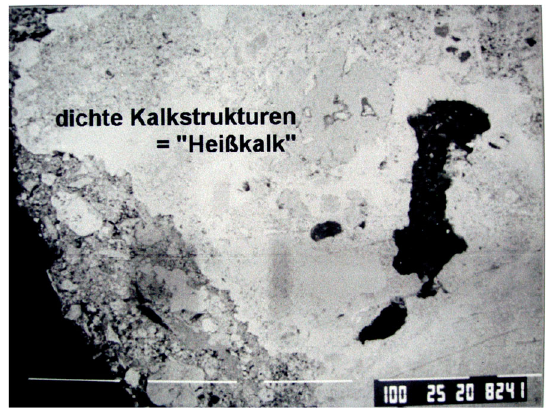
Fig. 16 Bratislava, castle, wall painting fragment of Regnum Maravorum (B1), 2nd half of the ninth century; favored by ‘ dry- slaking ’ (i.e. the mixture of non-washed sand and fresh lime before slaking), the fine silicates cause hydraulic reactions; analysis Hubert Paschinger, Federal Heritage Office, Vienna, No. 1240/98 (Source: Hammer 2008,122)